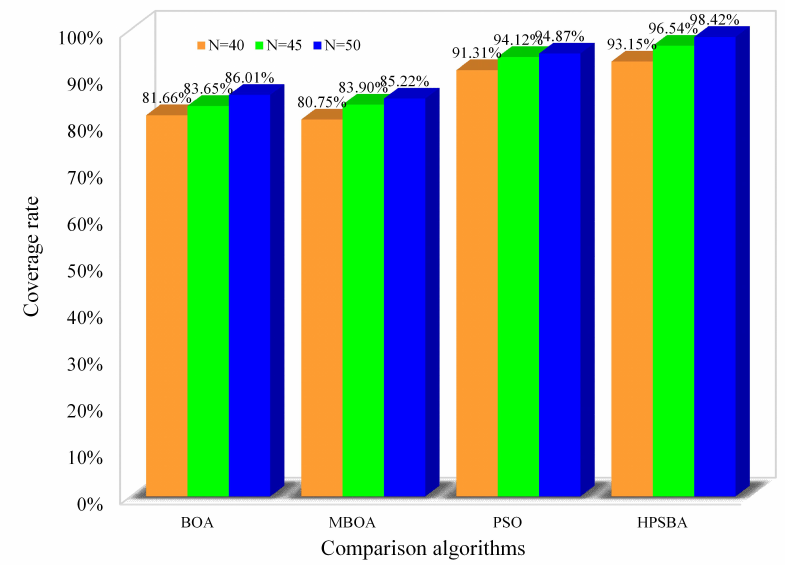
Figure 12. Coverage rates of different number of